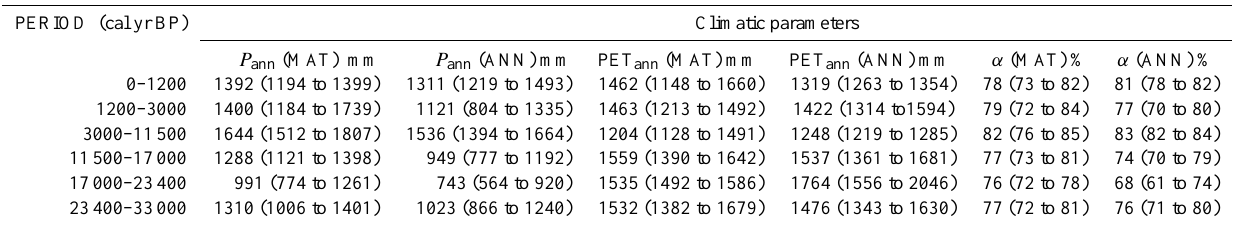
Table 6. Mean and minima and maxima range (between brackets) values of the 878 reconstructed climatic parameters in the Barombi Mbo pollen